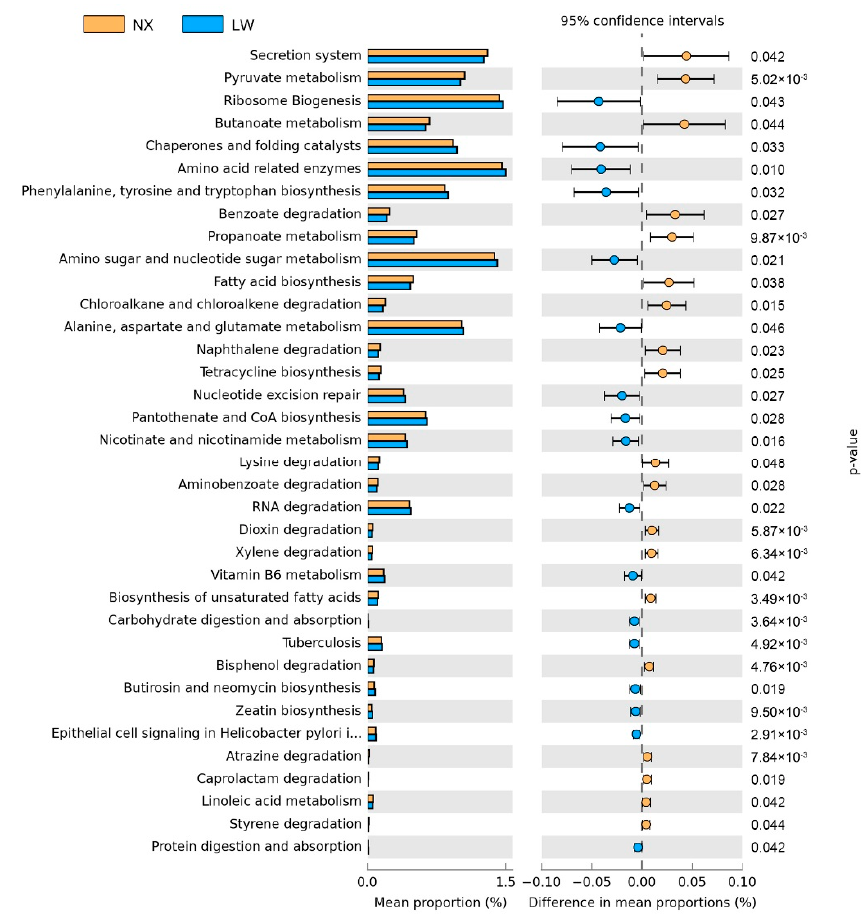
Figure 4. Prediction of changed the Kyoto encyclopedia of Genes and Genomes (KEGG) pathways using PICRUSt (plogenetic investigation of communities by reconstruction of unobserved states) analysis between the two pig breeds. LW, Large White; NX, Ningxiang. Table 2. Concentrations of short-chain fatty acids (SCFAs) in the cecal digesta in Ningxiang pig and Large White